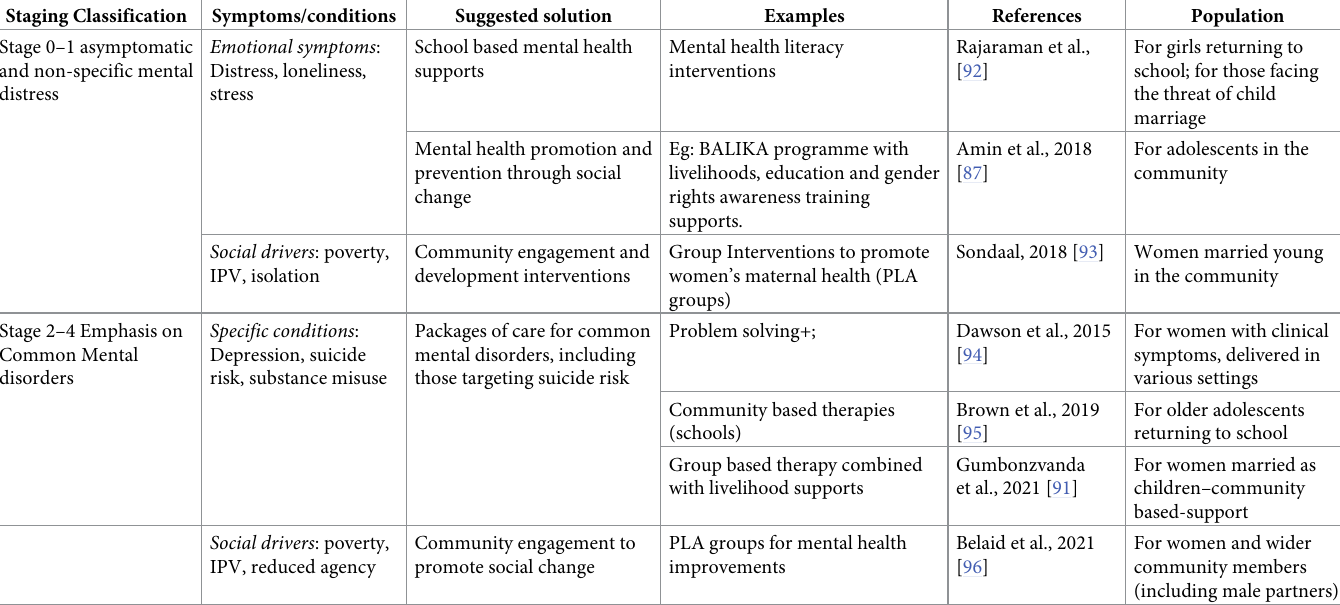
Table 4. Potential solutions for targeting mental distress linked to child